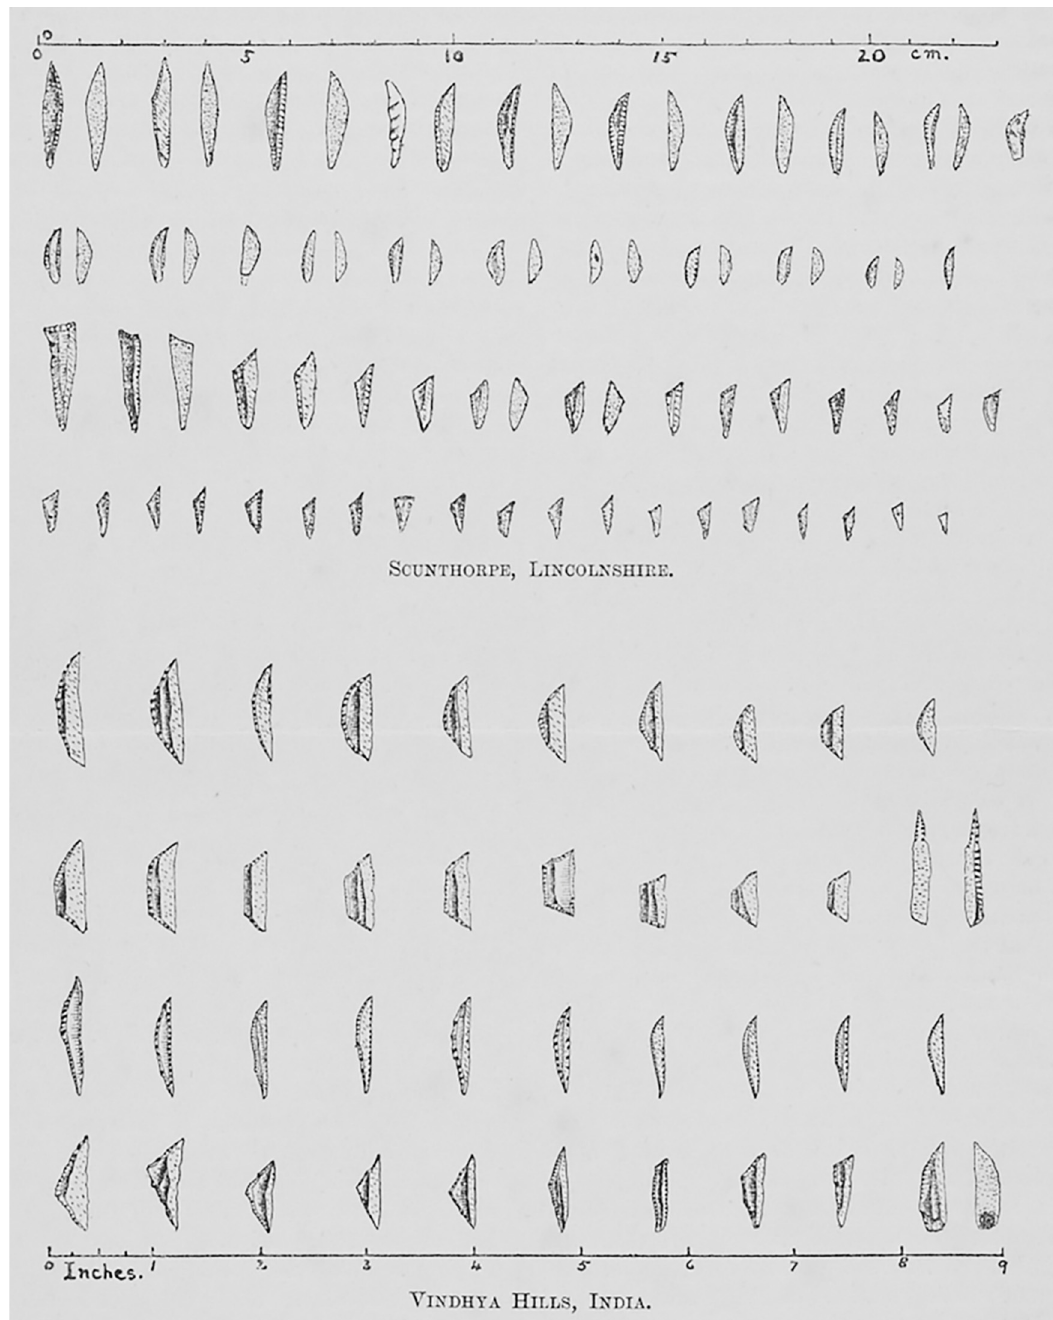
Figure 1: Illustrations of “ pigmy fl ints ” from Scunthorpe, Lincolnshire and Vindhya Hills, India, showing their similarity in form ( Gatty, 1905b, p. 296 )